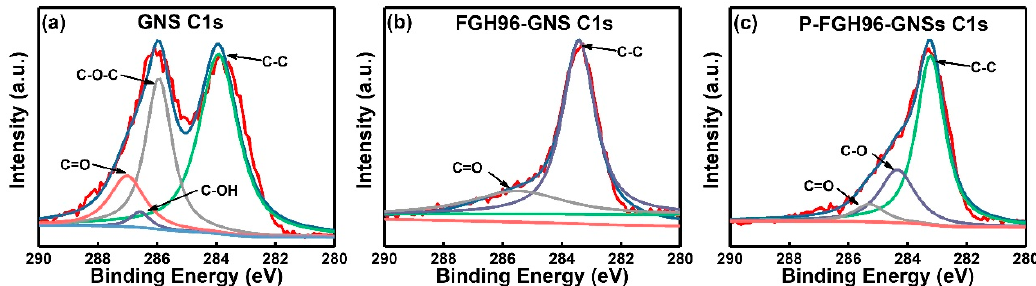
Figure 7. C 1s XPS spectrum of the pristine GNSs ( a ), FGH96-GNSs powder ( b ), and P-FGH96-GNSs powder ( c ).